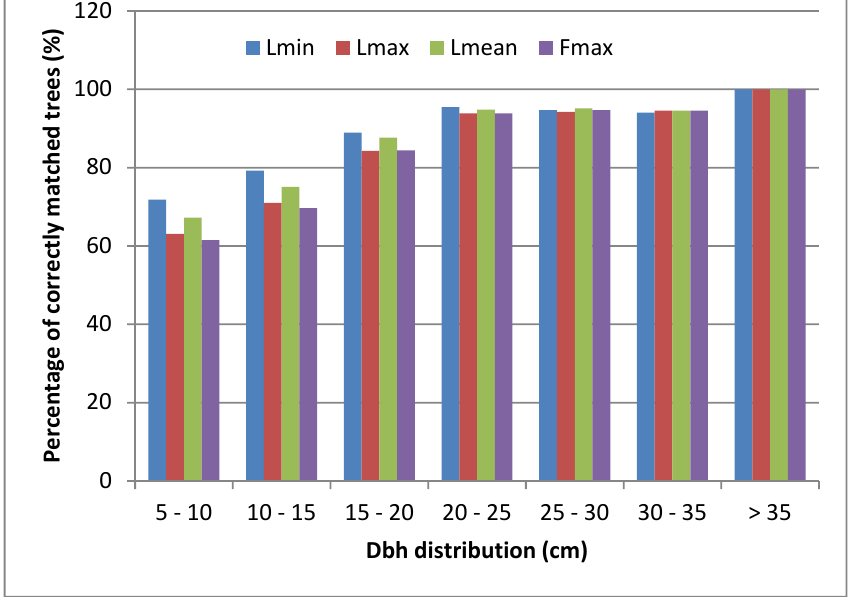
Figure 5. The percentage of correctly matched trees as a function of diameter breast height